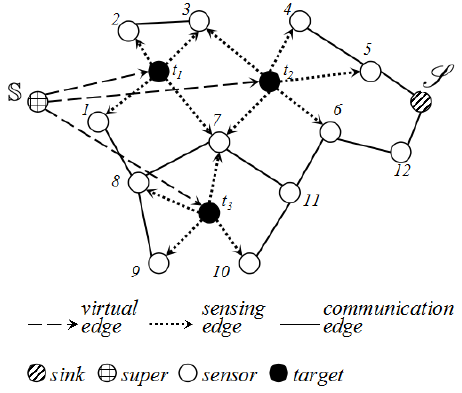
Figure 5. An example of the flow